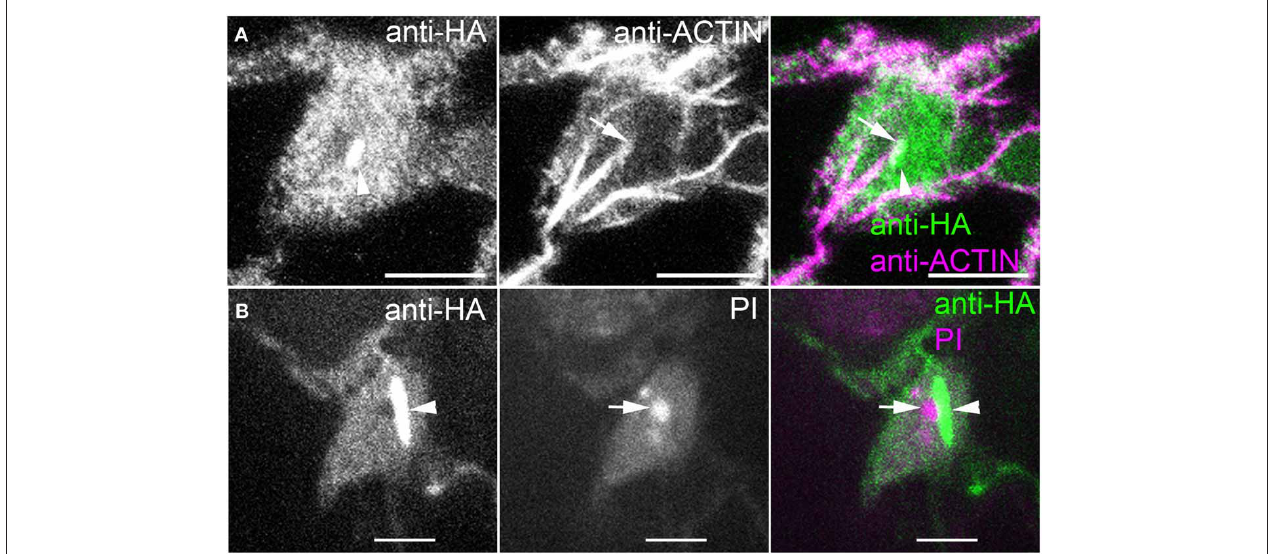
FIGURE 4 | ARP2/3 is localized to the nucleus and is concentrated within a rod-like structure that is adjacent to the nucleolus. (A) Double labeling of ARPC4HA and ACTIN in the nucleus region of a pavement cell. Arrowhead, perinucleolar ARP2/3-positive rod, arrow, actin bundle that terminates at one